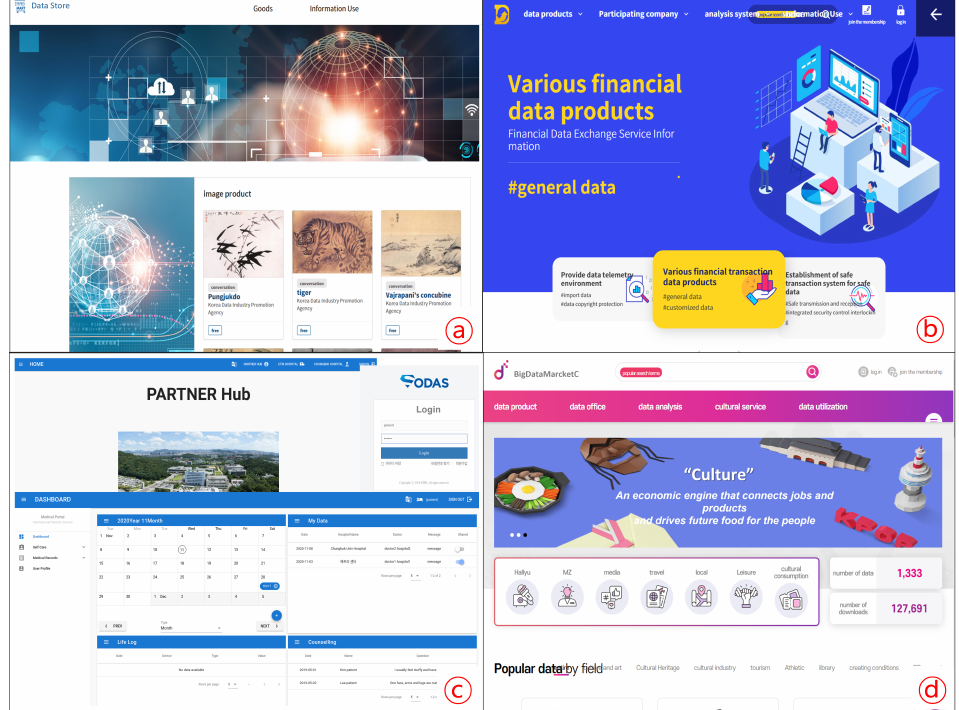
Figure 16. SODAS-based actual operation